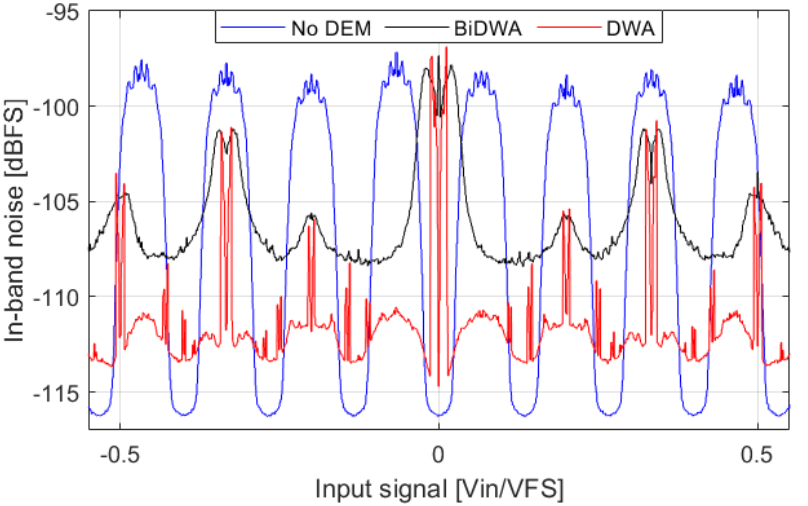
Figure 14. IBN power comparison for the following cases: no DEM, DWA, and Bi − DWA. In total, 300 simulations have been averaged. Input signal is a slow ramp. Output signal is divided in segments of 2.69 ms. Σ∆ M parameters are: fourth-order, 4-bits, fs = 1.52 MHz, BW = 20 kHz, OSR = 38, OBG = 1.8, σ T =